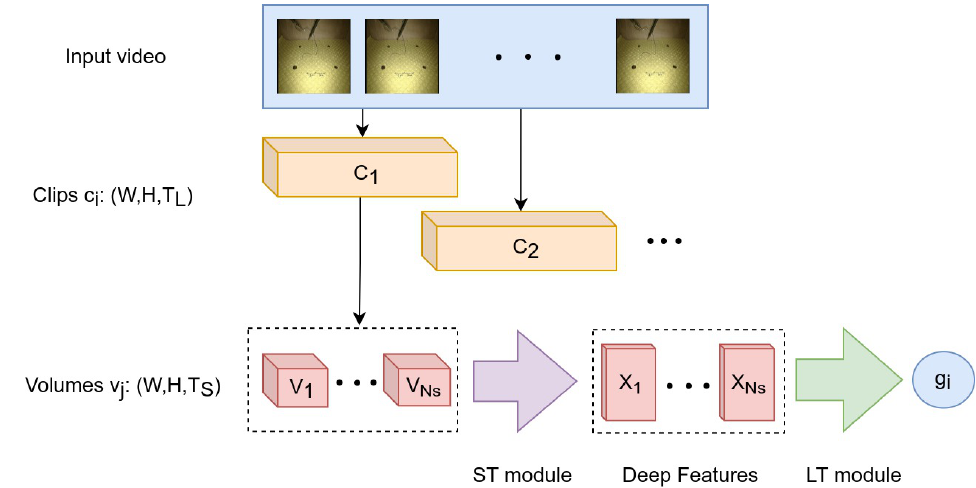
Figure 2. Overview of the proposed architecture using a two-level video decomposition approach. From each clip c i we extract N S volumes v j . The volumes are fed into the ST module providing a sequence of N S deep features X i , which are then fed into the LT module in order to predict the gesture class g i for the current clip c i